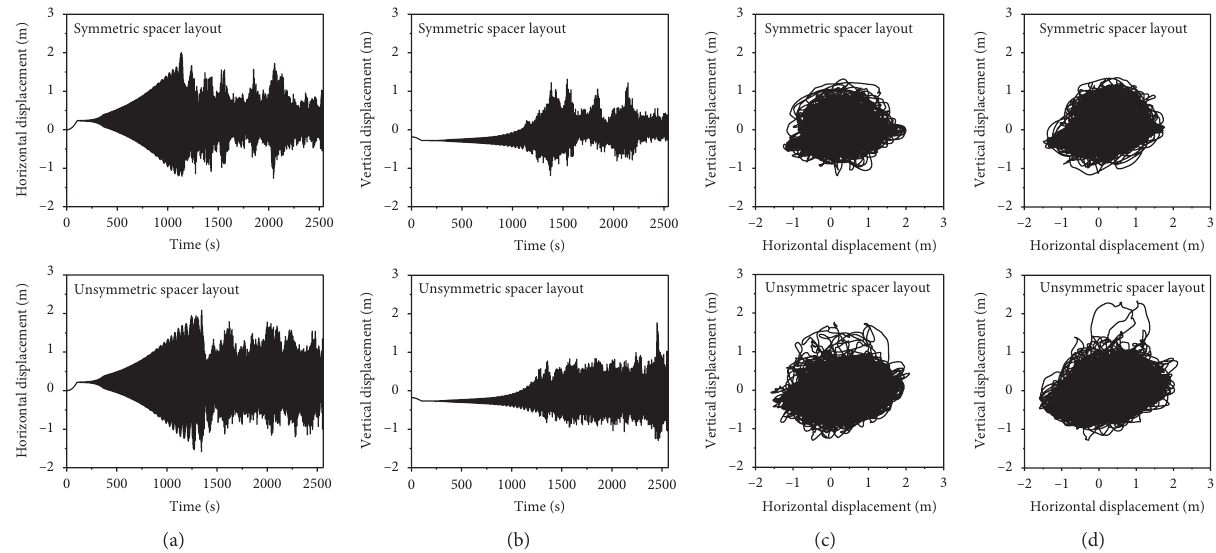
Figure 14: Time histories of displacement on subconductor 1 and motion traces of two subconductors at the subspan 3 midpoint of the line with an unsymmetric spacer layout ( I � 500A α � − 35 ° ): (a) horizontal displacement of subconductor 1, (b) vertical displacement of subconductor 1, (c) motion traces of subconductor 1, and (d) motion traces of subconductor